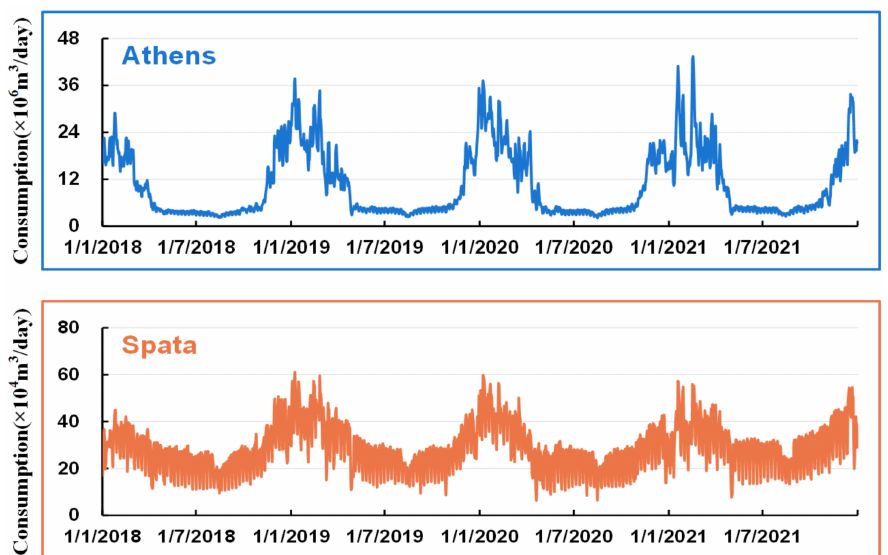
Figure 5. Consumption curves in two datasets with different fluctuation characteristics.